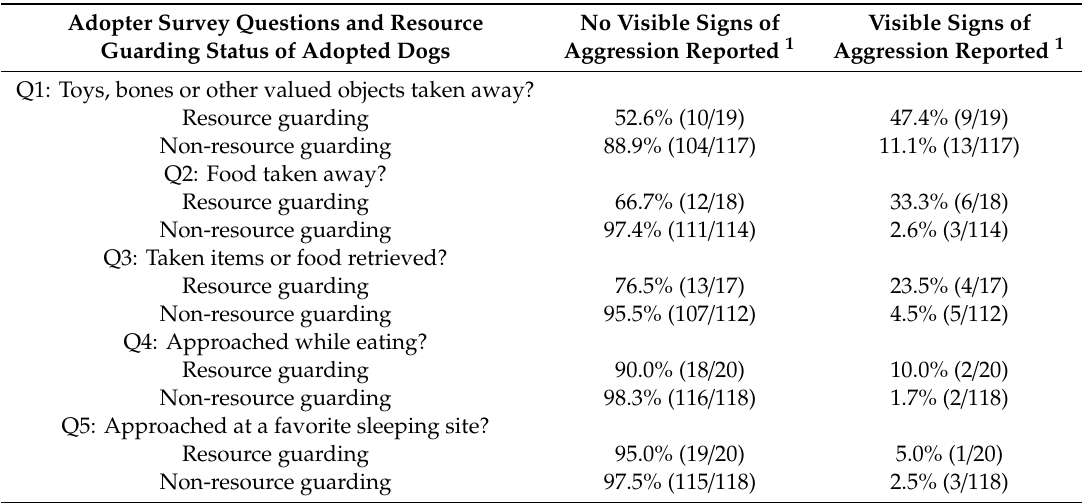
Table 3. Responses of adopters to survey questions about how their dog responds to five di ff erent situations in the home (Q1–Q5). Dogs are classified as resource guarding ( n = 20) or non-resource guarding ( n = 119) based on behavioral evaluations at the shelter before